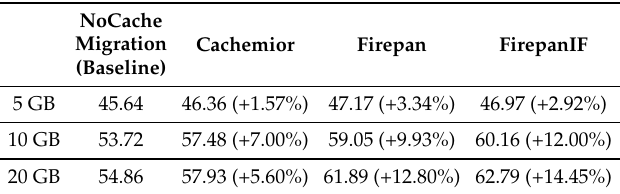
Table 3. Average bandwidth during 800 s after VM